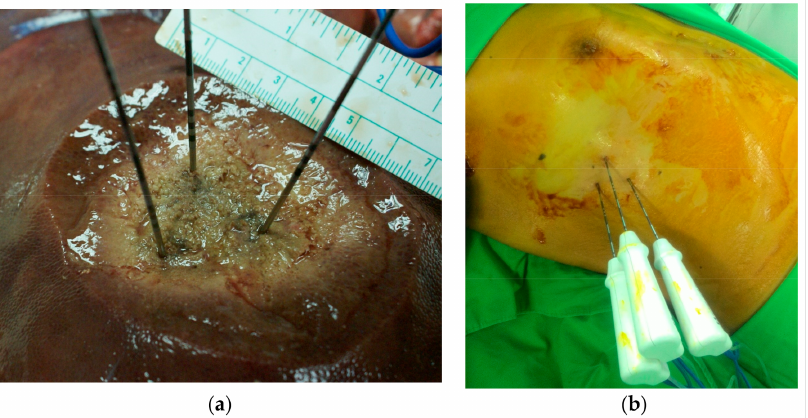
Figure 2. ( a ) multielectrode RFA can enlarge the ablation zone to 5 cm in diameter; ( b ) percutaneous multielectrode